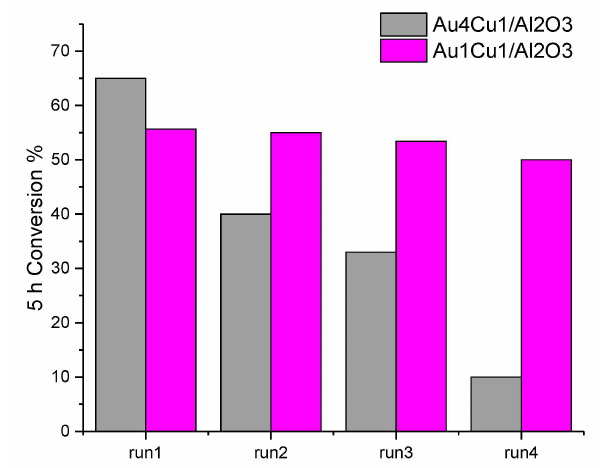
Figure 12. Recycle tests. VA oxidation in p-xylene (0.15 mol L − 1 ), VA: metal molar ratio 1000:1, 80 ◦ C and 2 bar of O 2